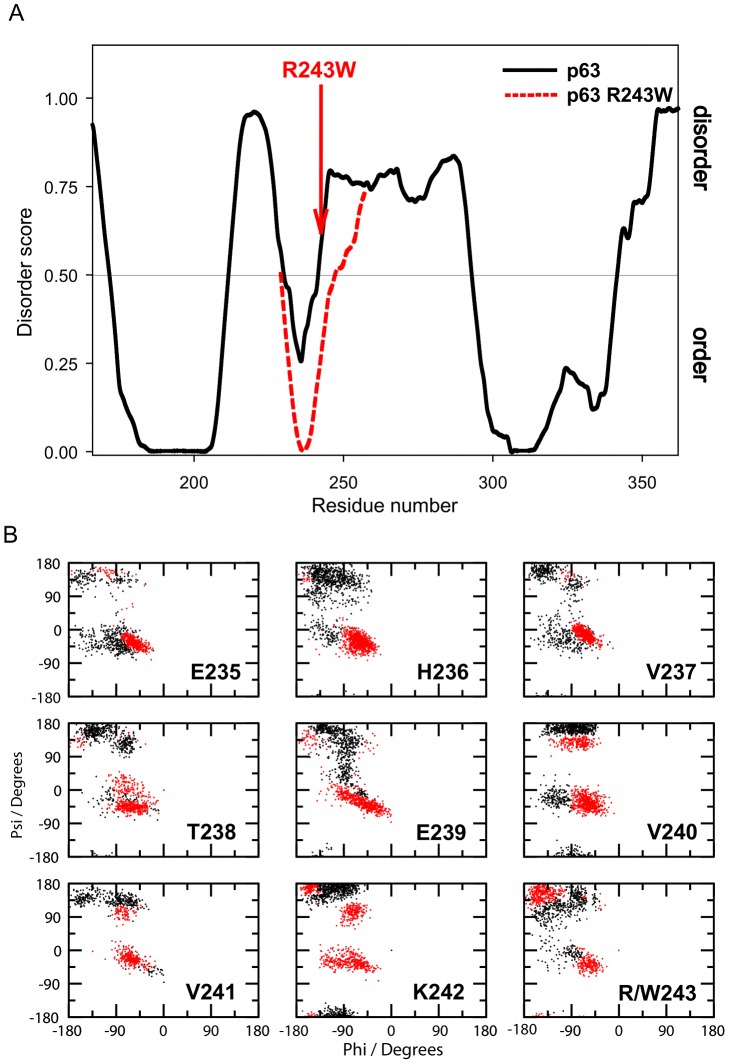
Disorder predictions and the effect of a R243W missense mutation in human protein p63.(A) PONDR VLXT disorder predictions for wild type and mutant p63. R243W mutation causes drop in the disorder score of 235–245 region. (B) Differential free energy weighted φ/ψ propensity plots for residues 235–243 obtained from AMD simulations performed on the wild-type and R243W mutant p63 DBD systems. The red dots represent those regions of the Ramachandran plot more heavily sampled by the mutant and the black dots represent those regions with greater propensity in the wild-type system.